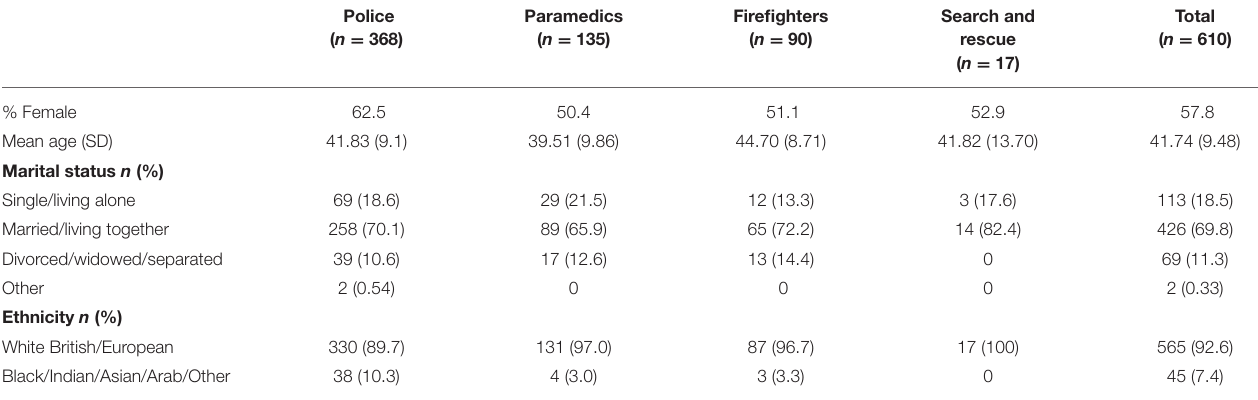
TABLE 1 | Participant demographic